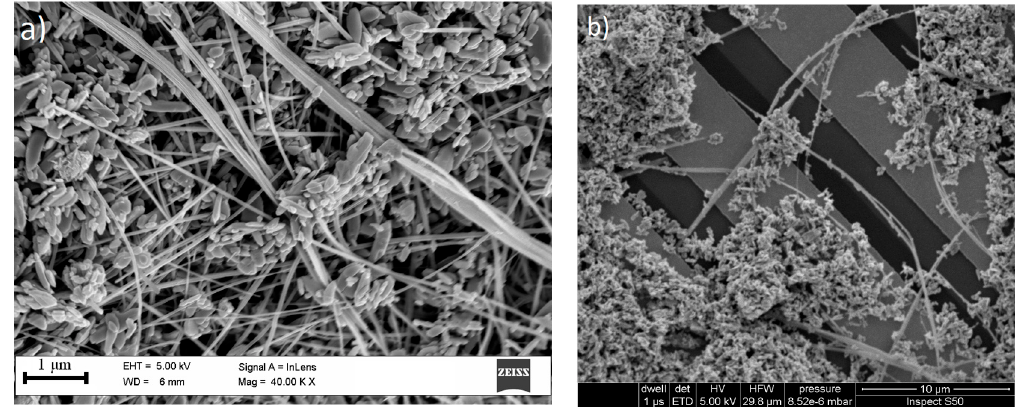
Figure 3. SEM images of: ( a ) ZnO nanostructures; ( b ) distribution of ZnO nanostructures on IDT.